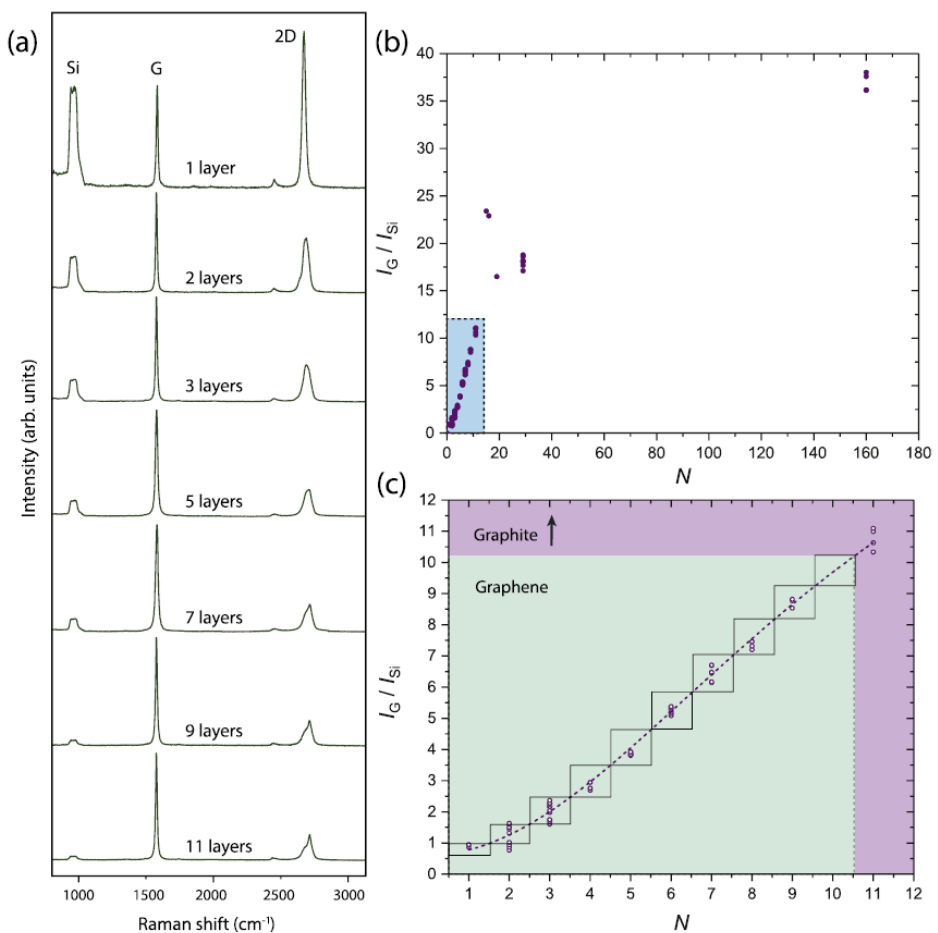
Figure 7. ( a ) Representative Raman spectra of different graphene flakes varying from monolayer to few-layer to multi-layer graphene; ( b ) a plot of the experimental values obtained from the ratio intensity of the G-band to Raman signals from the Si substrate; ( c ) a magnified view of the ( b ) graph from monolayer to multi-layer graphene [79].